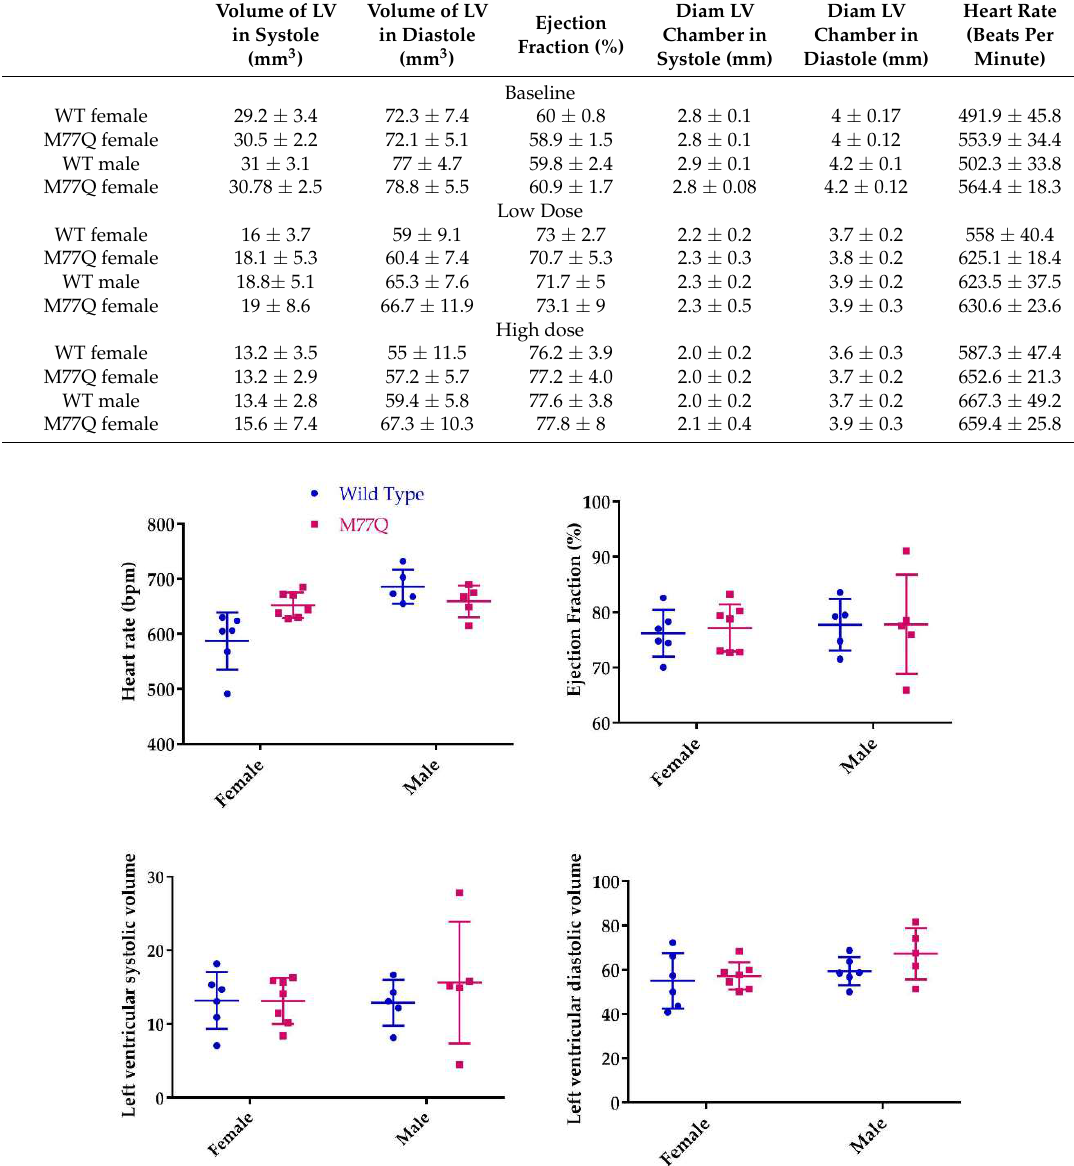
Figure 6. Cardiac parameters during high dose dobutamine stress test at 6 months of age. Except for the female heart rates ( p = 0.05), none of the comparisons were statistically significantly different.